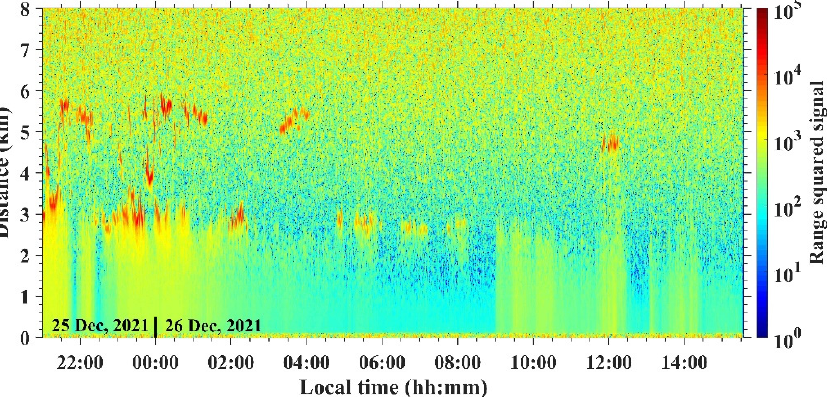
Figure 9. Temporal and spatial evolution of the range squared signal from 25–26 December 2021 with a temporal resolution of 1 min and a spatial resolution of 9.8 m.